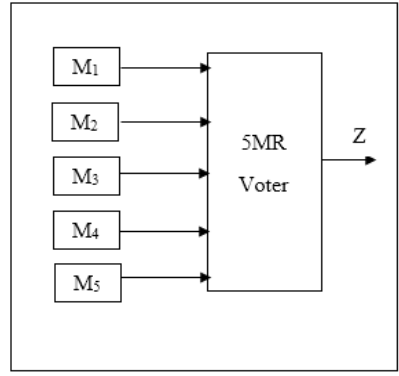
Figure 4. Penta modular redundancy-based field programmable gate arrays (FPGA). Proposed Design